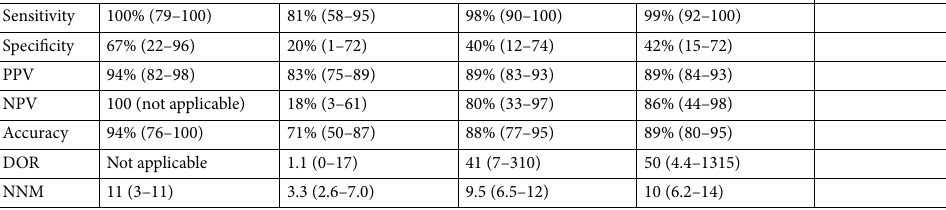
Table 5. Performance of noninvasive diagnostic modalities.